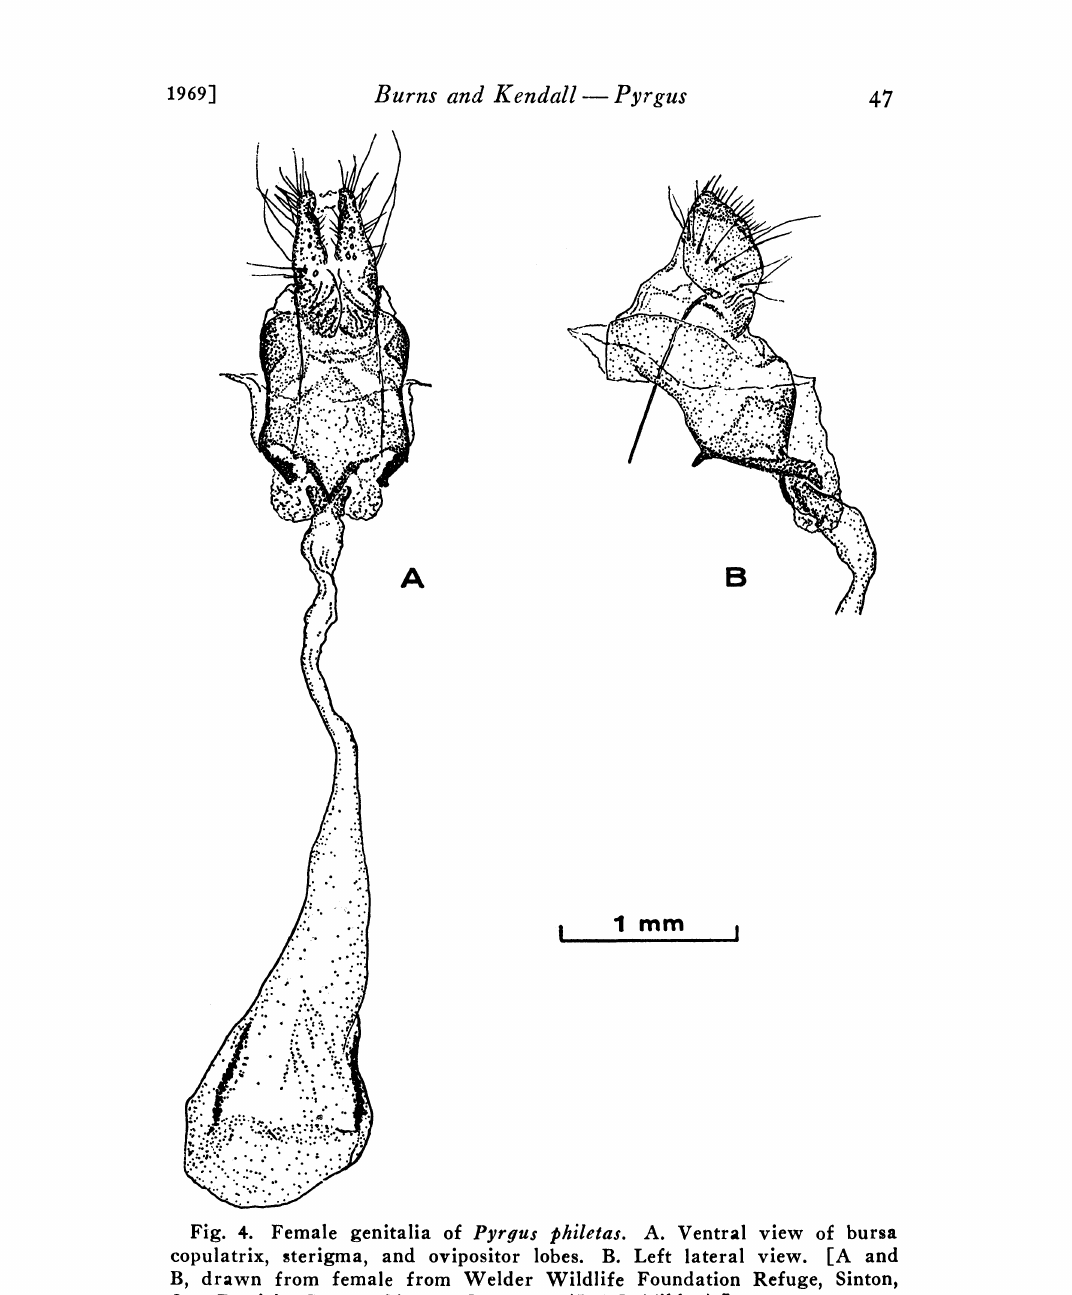
Fig. 4. Female genitalia of Pyrgus philetas. A. Ventral view of bursa copulatrix, zterigma, and ovipositor lobes. B. Left lateral view. [A and B, drawn from female from Welder Wildlife Foundation Refuge, Sinton, San Patricio County, Texas, X-13-1963 (J. W.